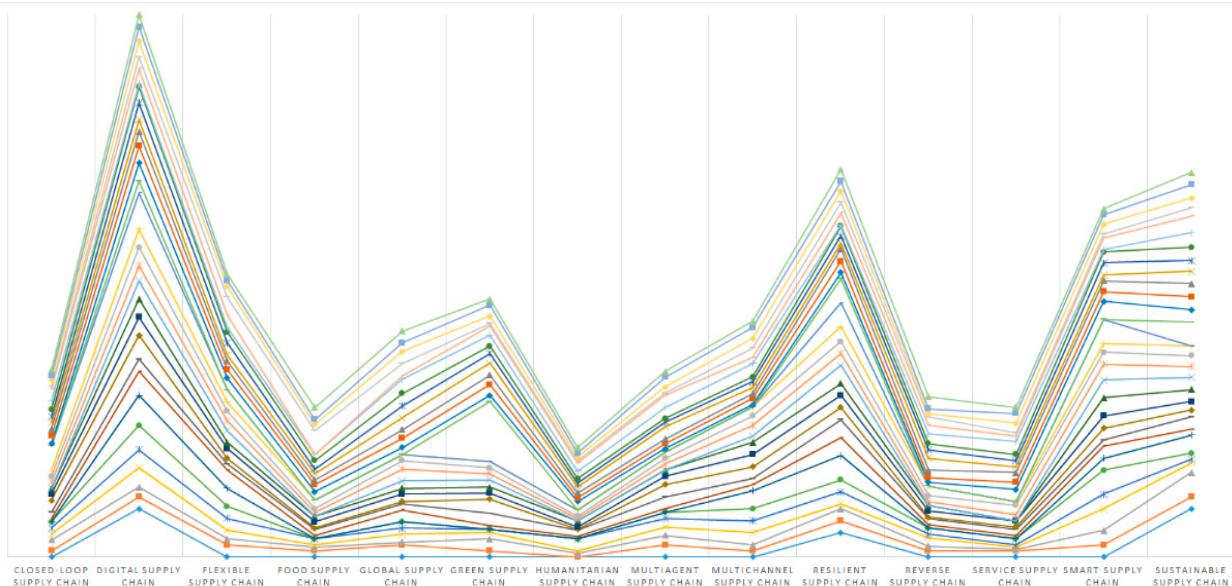
Figure 9. Ranking graph of global theoretical trends and supply chain development directions in the context of the dynamic development of technology and production organization (Industry 4.0) according to the experts’ assessments 1–30; own elaboration based on the conducted research.